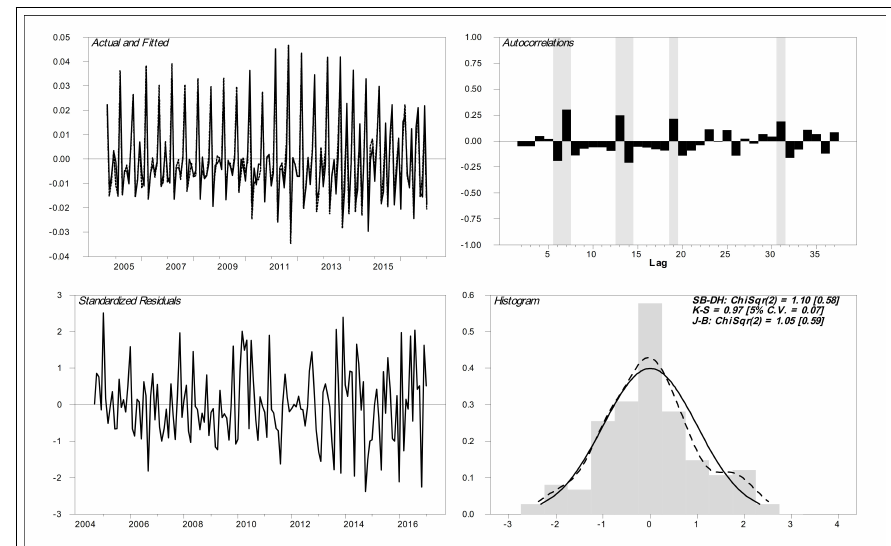
Figure 2: Graphs of actual and fitted change in the Greek inflation rate (upper left hand side panel), the standardized residuals (lower left hand side panel), the residual autocorrelogram (upper right hand side panel), and the residual histogram compared to the normal distribution.